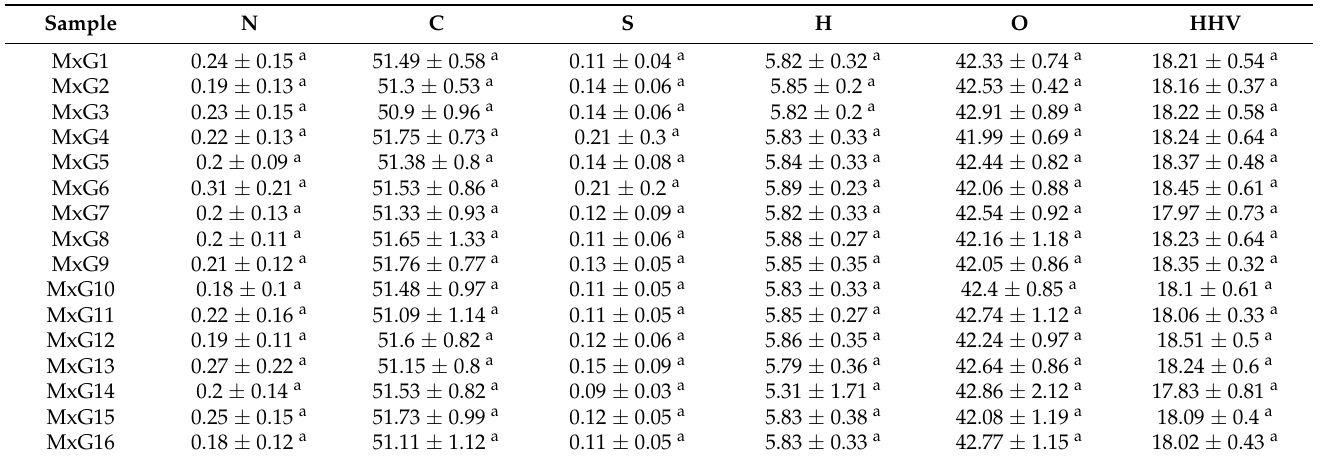
Table 2. Average values of nitrogen, carbon, sulfur, hydrogen, and oxygen of investigated biomass of miscanthus.